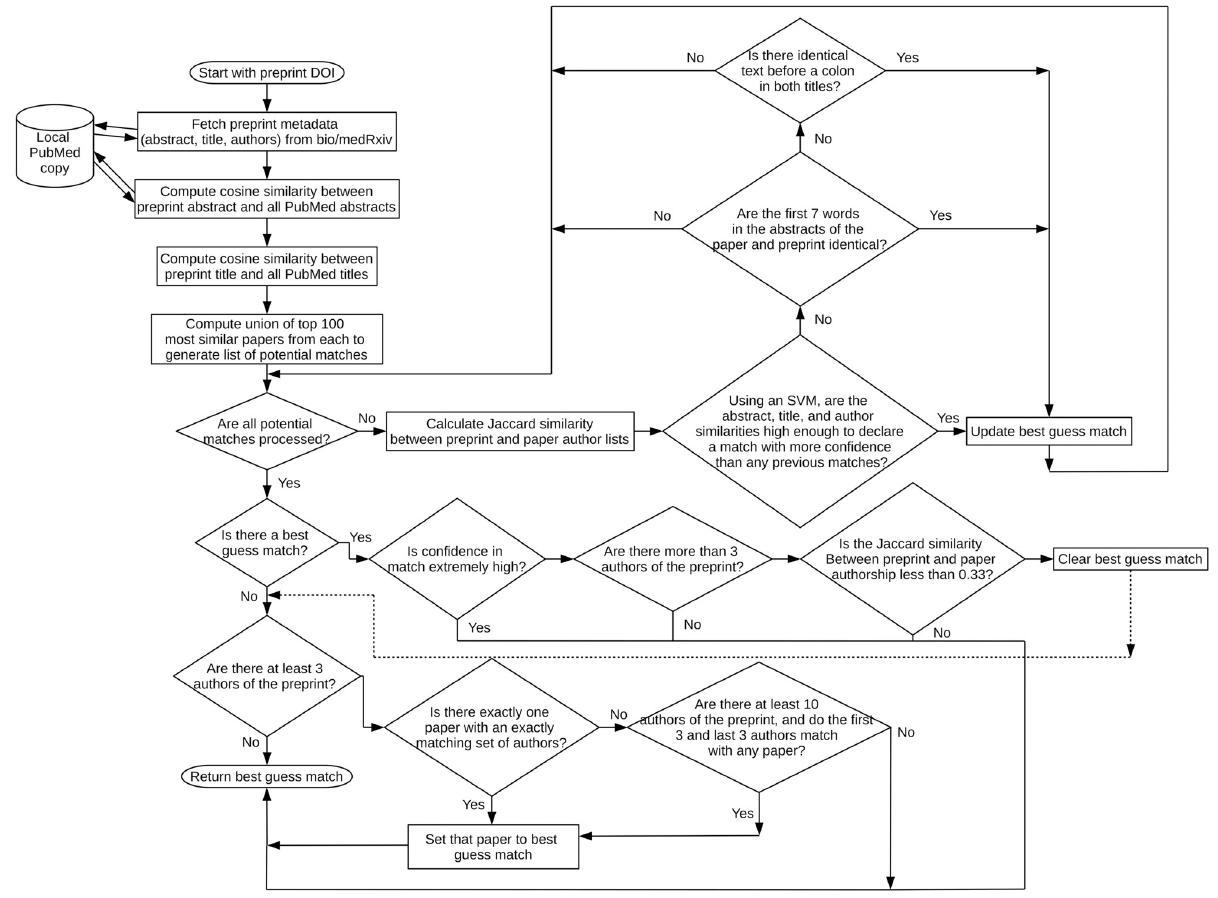
Fig 1. Description of